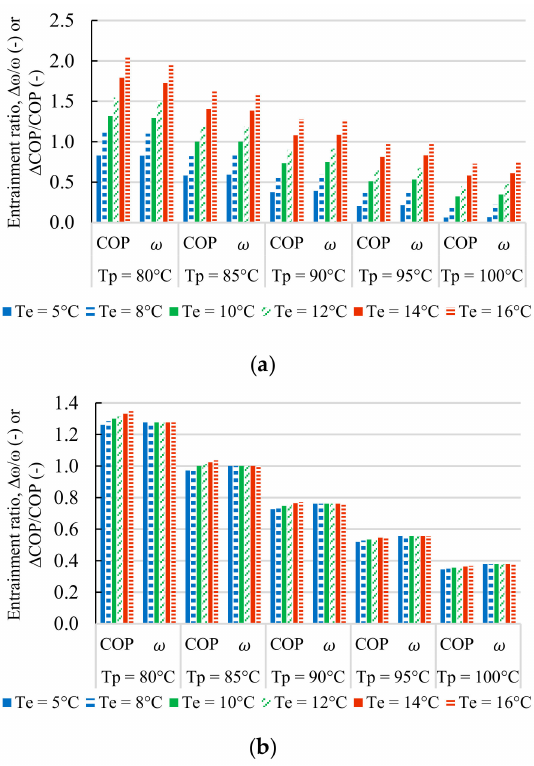
Figure 10. Sensitivity of the ejector entrainment ratio and refrigeration sub-system overall COP to the evaporator and primary flow inlet (generation) temperature for the simple Ejector A cycle and the compression-assisted Ejector C cycle with R245fa as the working fluid, normalized to a baseline entrainment ratio and overall COP of T p = 85 ◦ C and T e = 10 ◦ C: ( a ) Ejector A (SC); ( b ) Ejector C